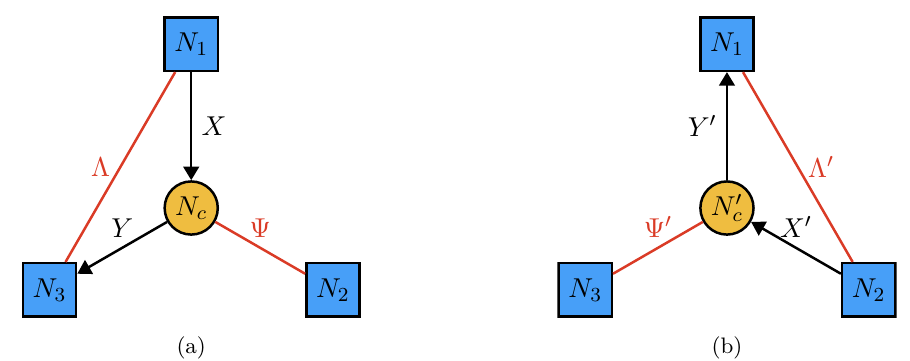
Figure 1 . 2 d N = (0 , 2) SQCD and its triality dual. The central nodes have ranks given in (2.1). text. Finally, in appendix C we give all the necessary details for the phases of Q 1 , 1 , 1 / Z involved in the triality web introduced in section